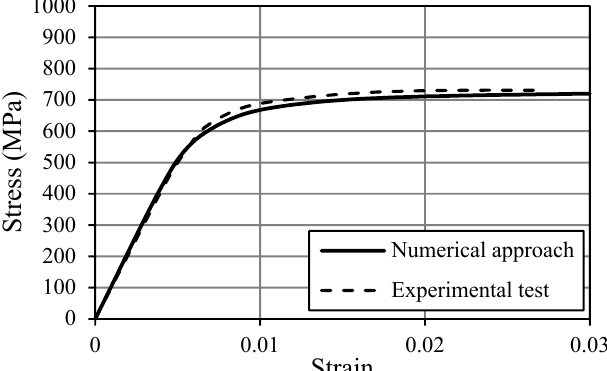
Figure 12. Comparison of the experimental and numerical outcomes of nanocrystalline copper with a grain size of 54 nm under tensile test